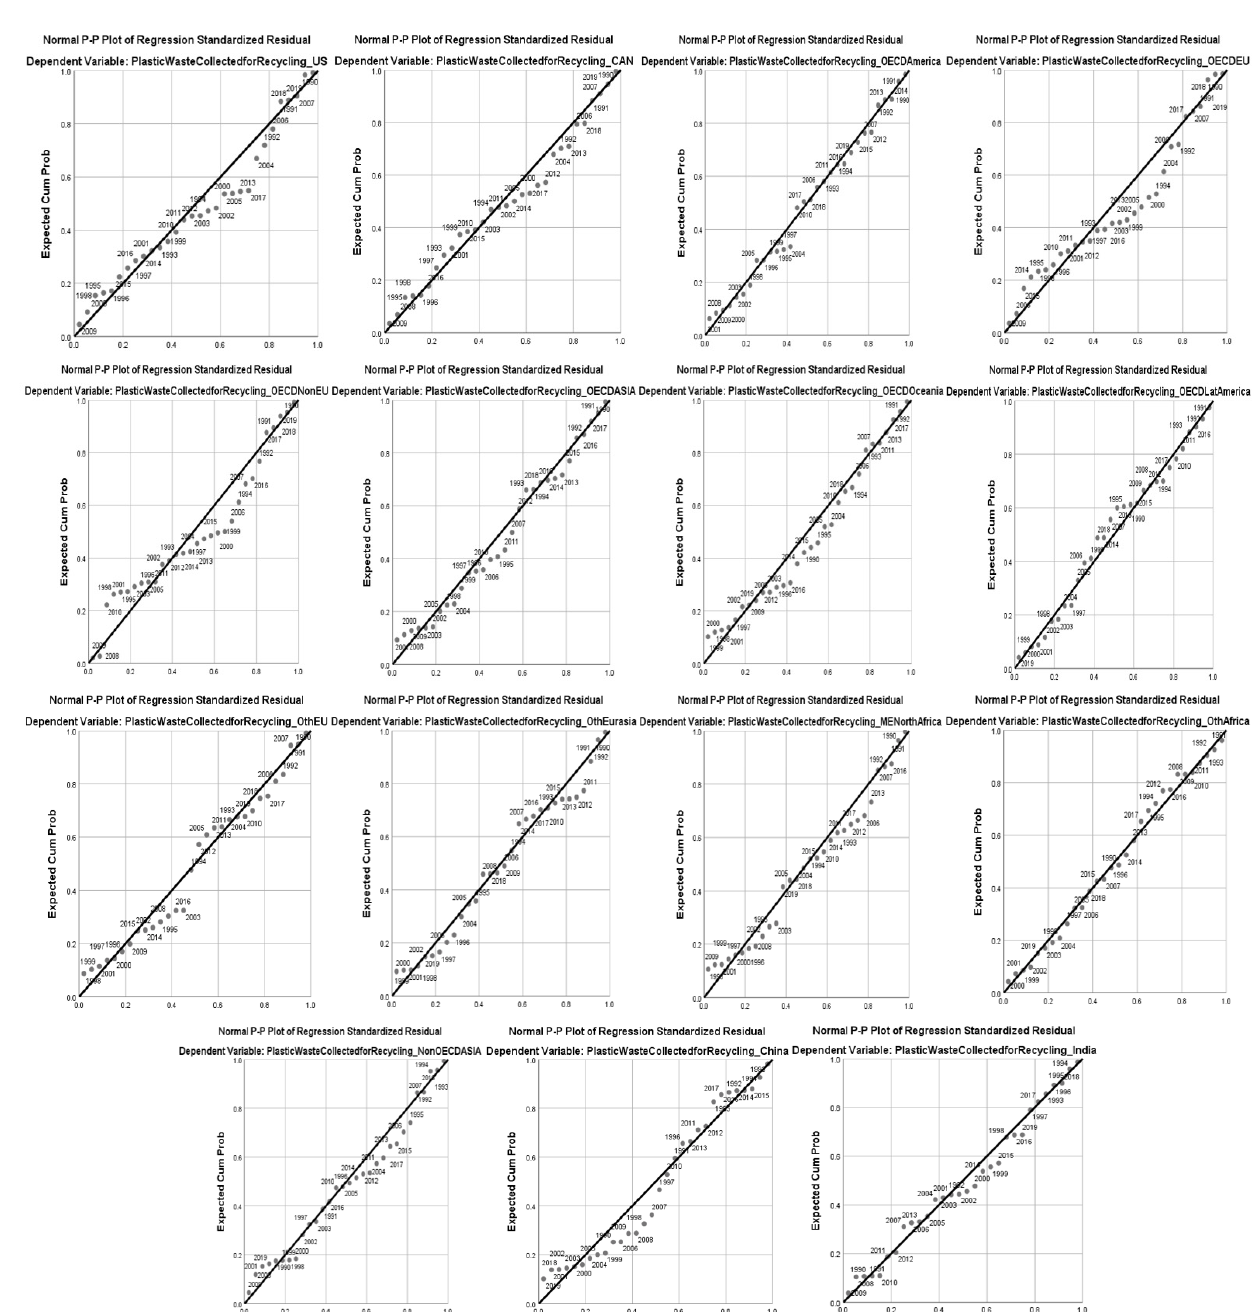
Figure 5. P-P Plot diagrams of regional distribution.